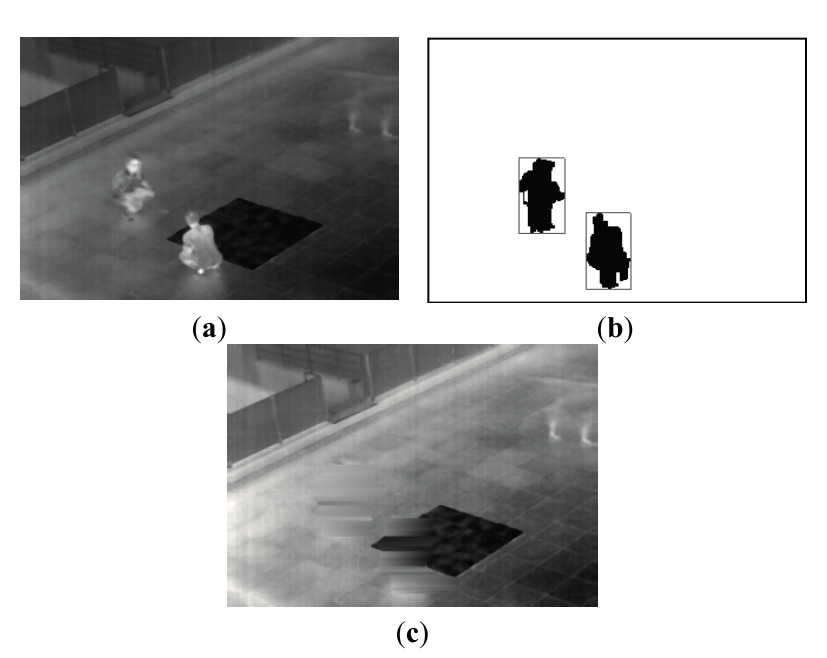
Figure 4. The first example for obtaining a background image from our database: ( a ) preliminary background image obtained by temporal averaging; ( b ) extracted human areas; and ( c ) the generated final background